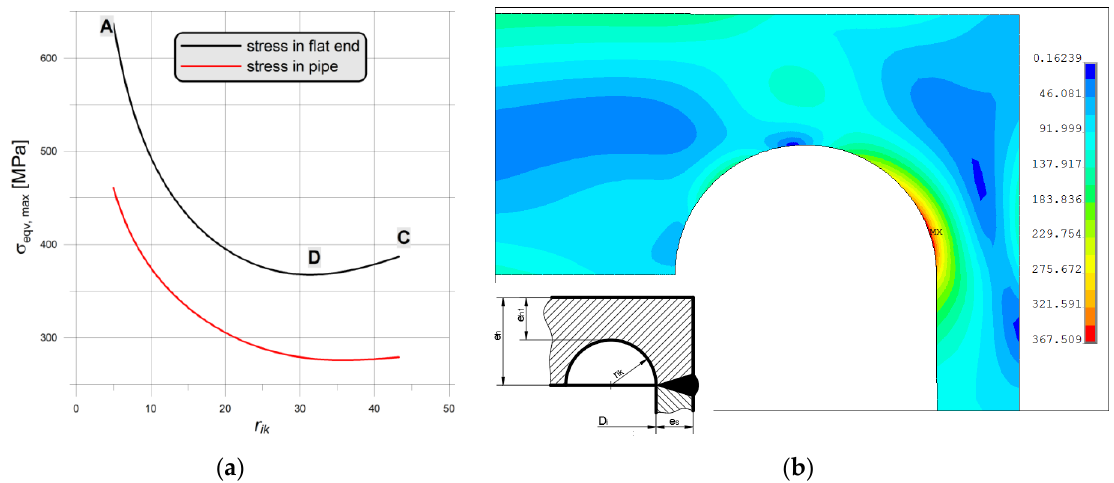
Figure 22. Bottom type “f”: ( a ) distribution of maximum equivalent stresses for pairs ( r ik , e h 1 ) placed along with line AC (see Figure 21b); ( b ) distribution of equivalent stresses in the groove for optimally chosen r ik .